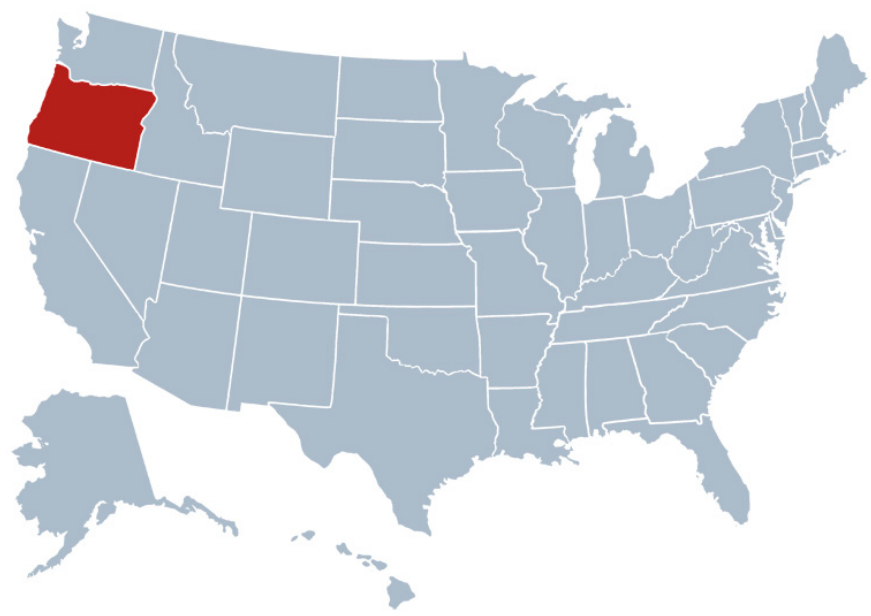
Figure 1. Location of Oregon, U.S.A. [44].